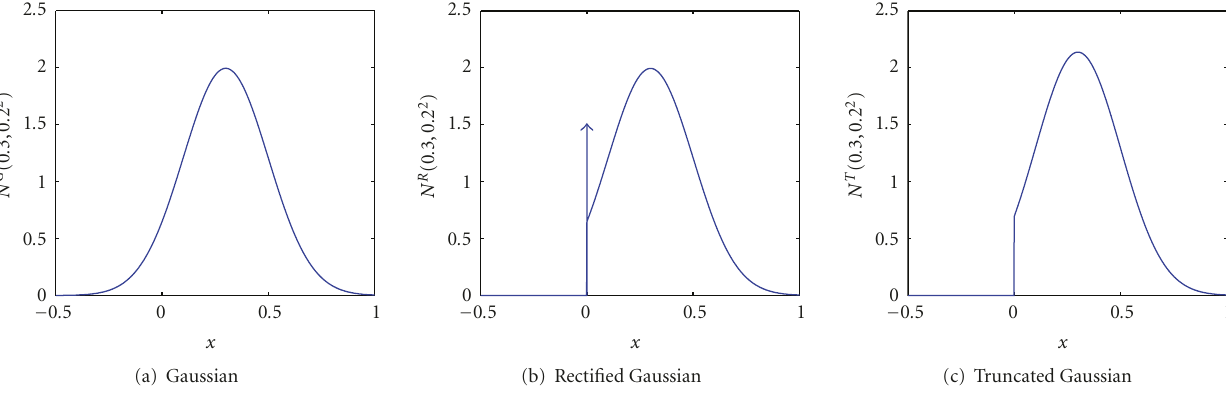
Figure 16: Comparison of the Gaussian, rectified Gaussian, and truncated